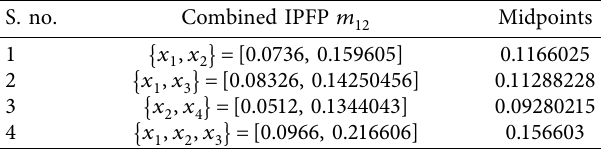
Table 3: Midpoint of combined IPFP. S.